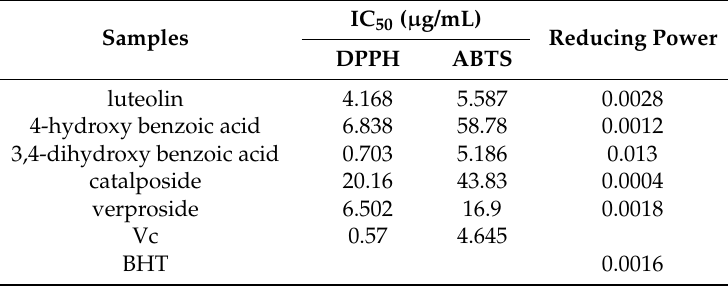
Table 3. The antioxidant activity of the five compounds.